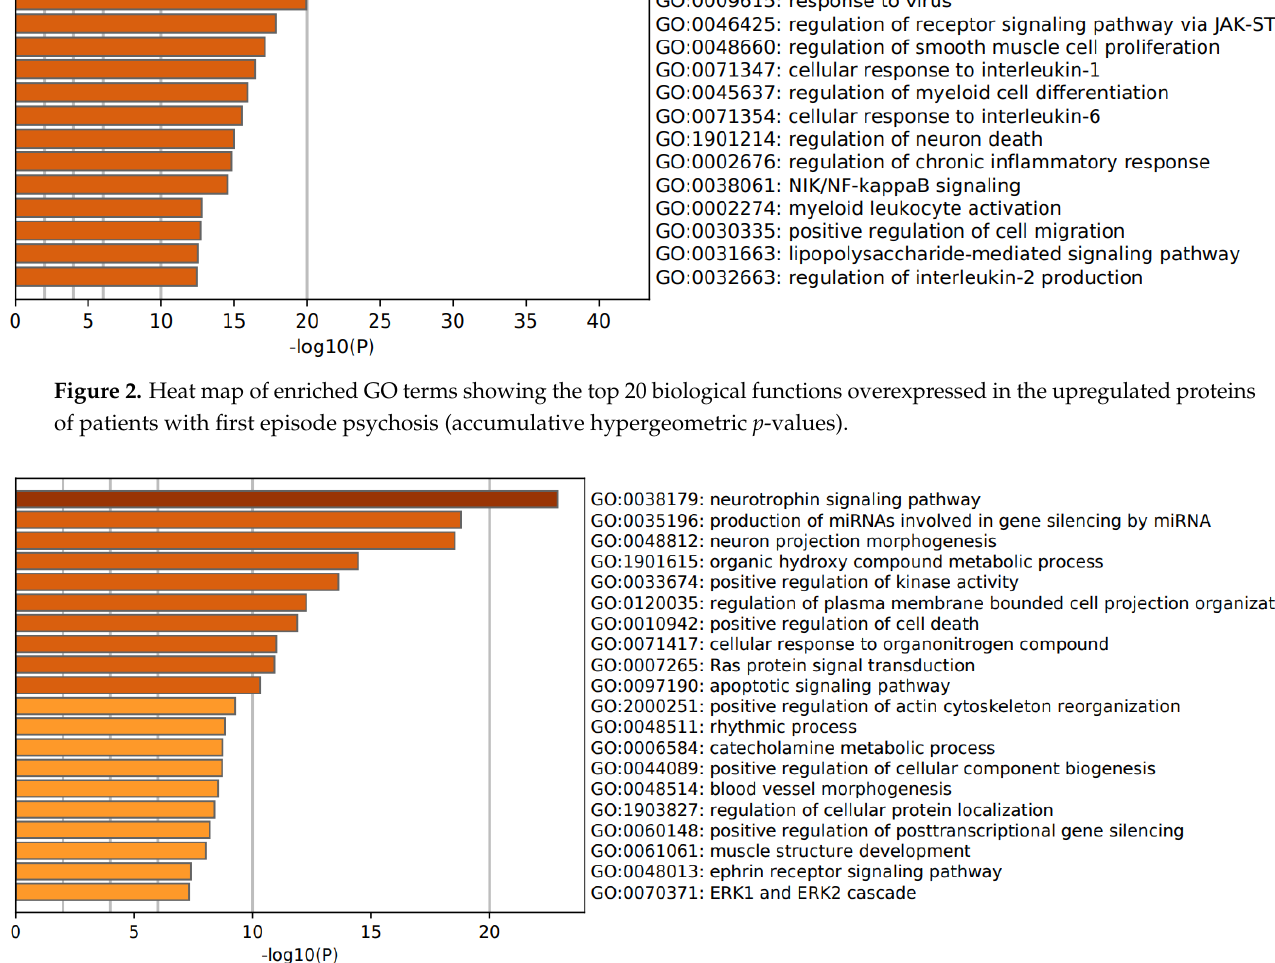
Figure 3. Heat map of enriched GO terms showing the top 20 biological functions associated with the downregulated proteins of patients with first episode psychosis (accumulative hypergeometric p -values).